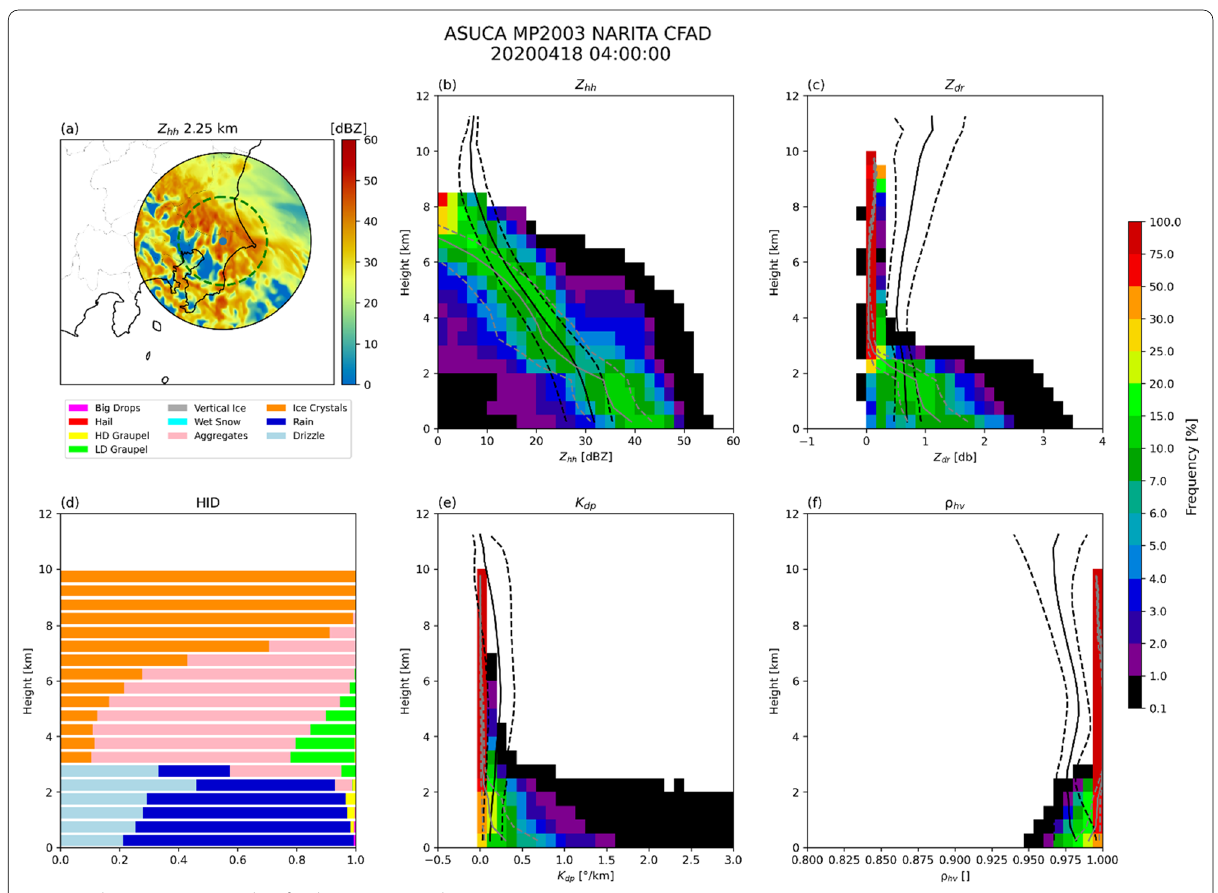
Fig. 17 The same as Fig. 15, but for the ASUCA